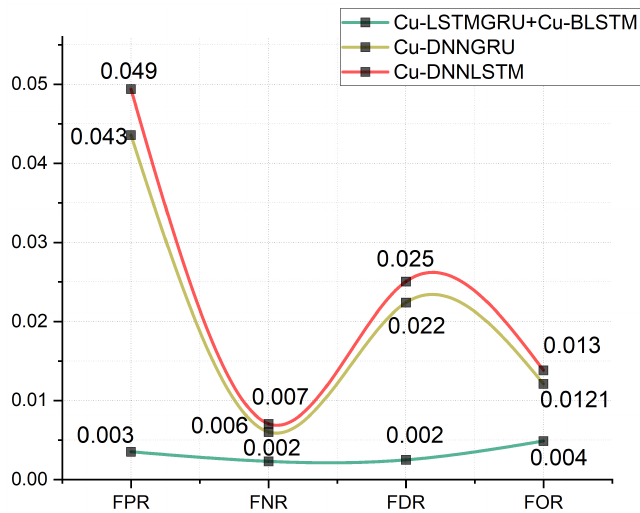
Figure 6. FPR, FNR, FDR and FOR Results.